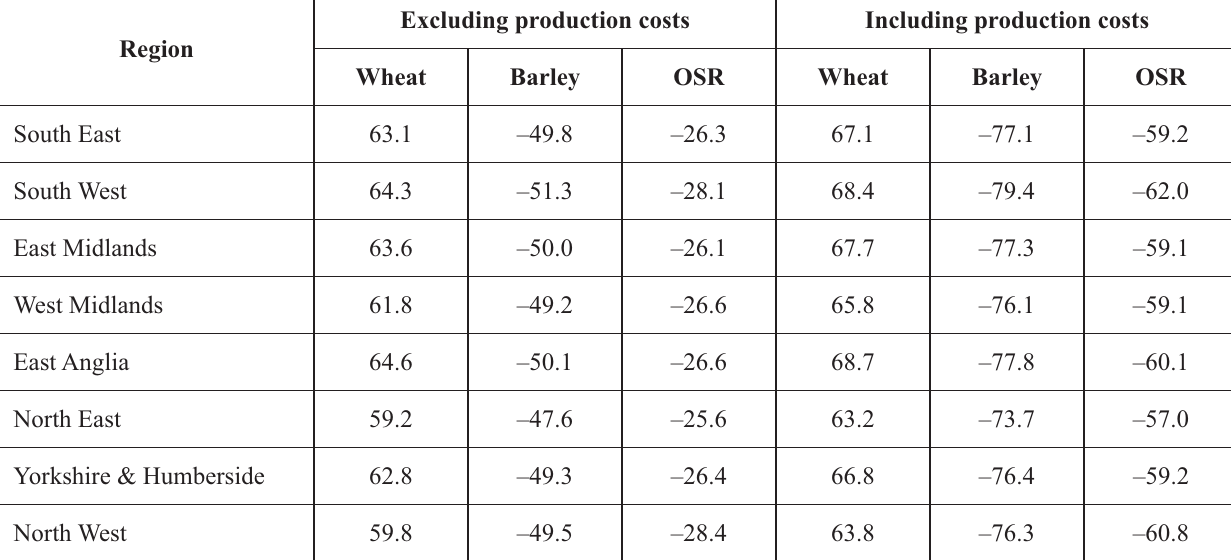
Table 4. Estimated Fixed Effects including and excluding production